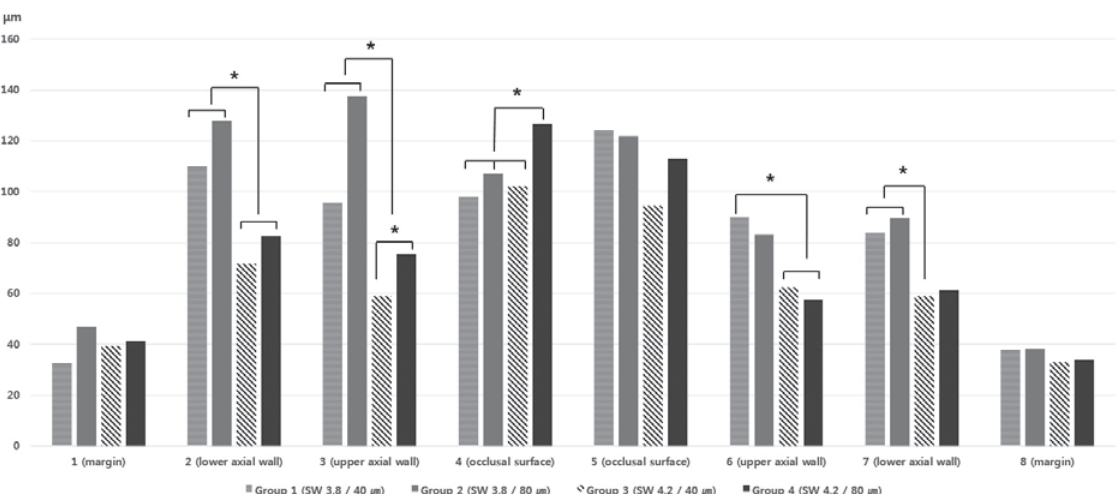
Figure 7- (cid:3)(cid:48)(cid:72)(cid:68)(cid:81)(cid:3)(cid:76)(cid:81)(cid:87)(cid:72)(cid:85)(cid:81)(cid:68)(cid:79)(cid:3)(cid:191)(cid:87)(cid:3)(cid:11) (cid:80) m) of each measuring points on buccolingually sectioned surface. *indicates statistically